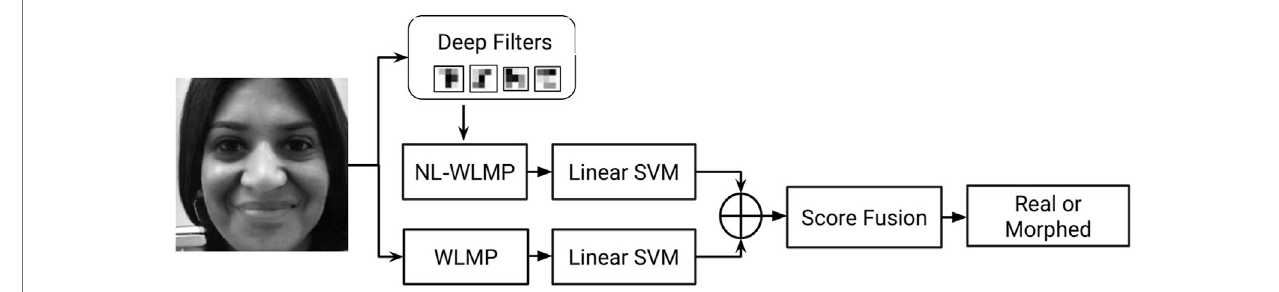
FIGURE 4 | Proposed MagNet algorithm using fusion of WLMP and